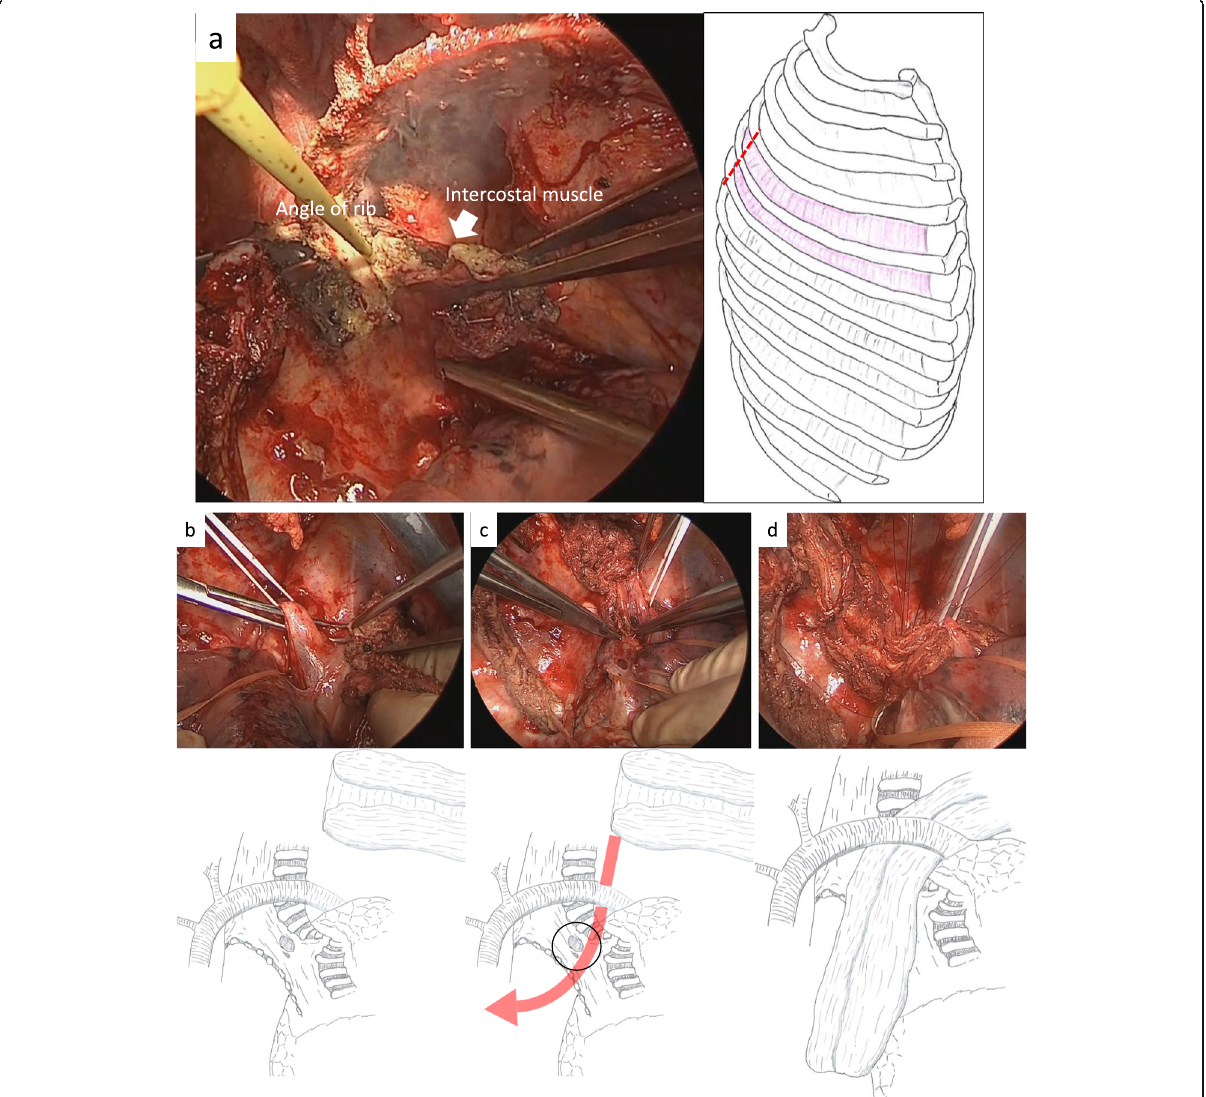
Fig. 4 Intraoperative views showing the separation of the fourth and fifth intercostal muscles near the angles of the ribs ( a ). Next, the arrow shows the passing of the muscle flap between the azygos vein and right upper lobe bronchus. The circle indicates the anastomosis site of the bronchus and intercostal muscle flap ( b , c ). Post-anastomosis findings show the muscle flap covering the fistula while being supported by the right upper bronchus from below ( d